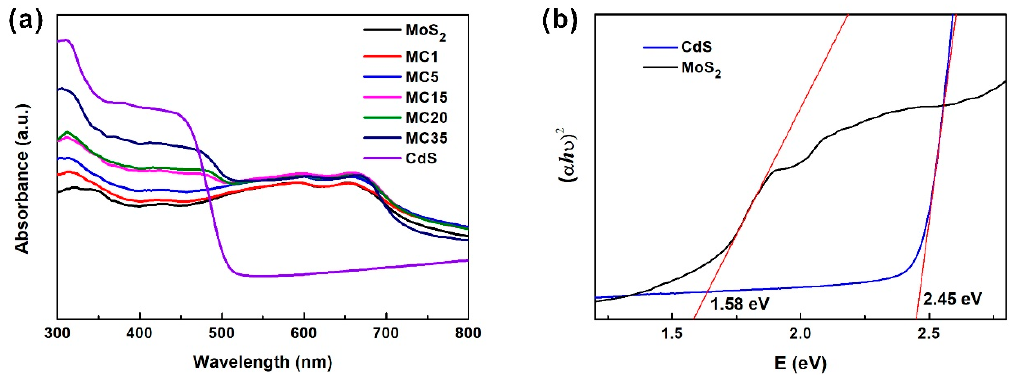
Figure 5. ( a ) UV-vis absorption spectra; ( b ) band gaps of MoS 2 and CdS estimated by ( α h υ ) 2 vs. photon energy